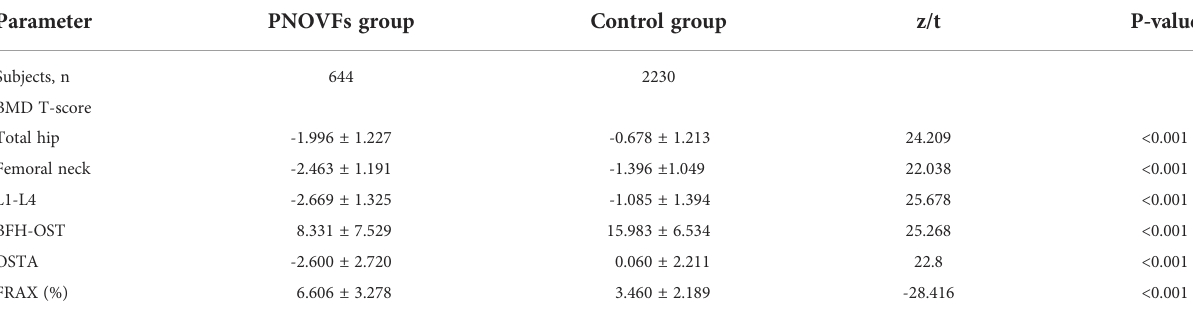
TABLE 3 BMD T-score, BFH-OST, and FRAX scores of the PNOVFs group and control